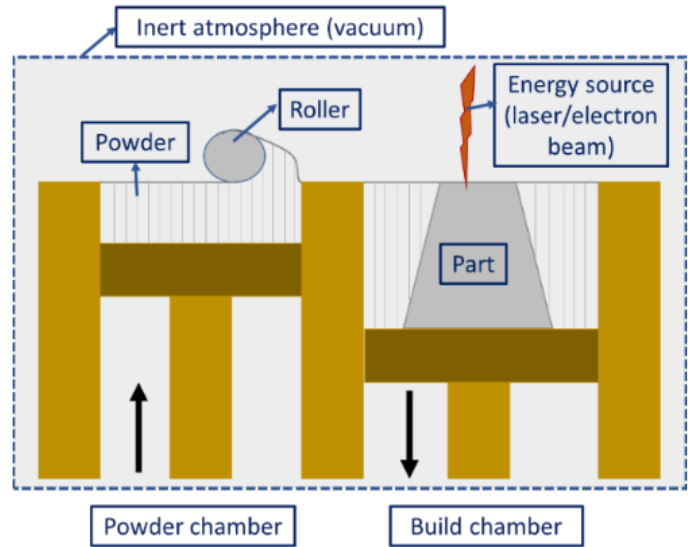
Figure 3. Schematic diagram illustrating the powder bed fusion process.